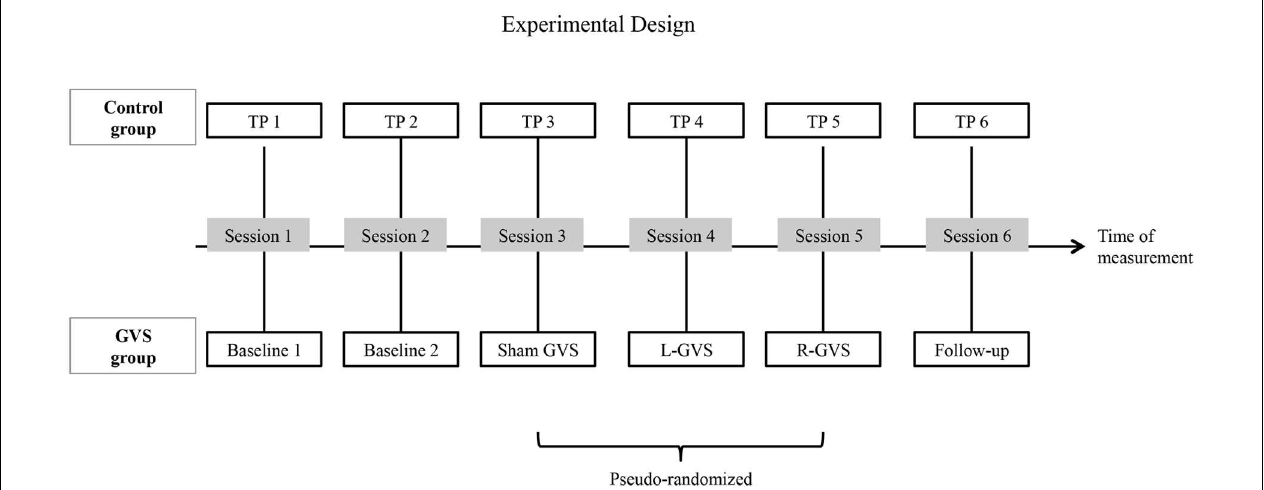
extinction, respectively in six different sessions. Abbreviations: L-GVS, left-cathodal/right-anodal GVS; R-GVS, right-cathodal/left-anodal GVS; Sham, Sham stimulation with GVS but without the application of current; Follow-up, mean follow-up 2.8months (84days) after